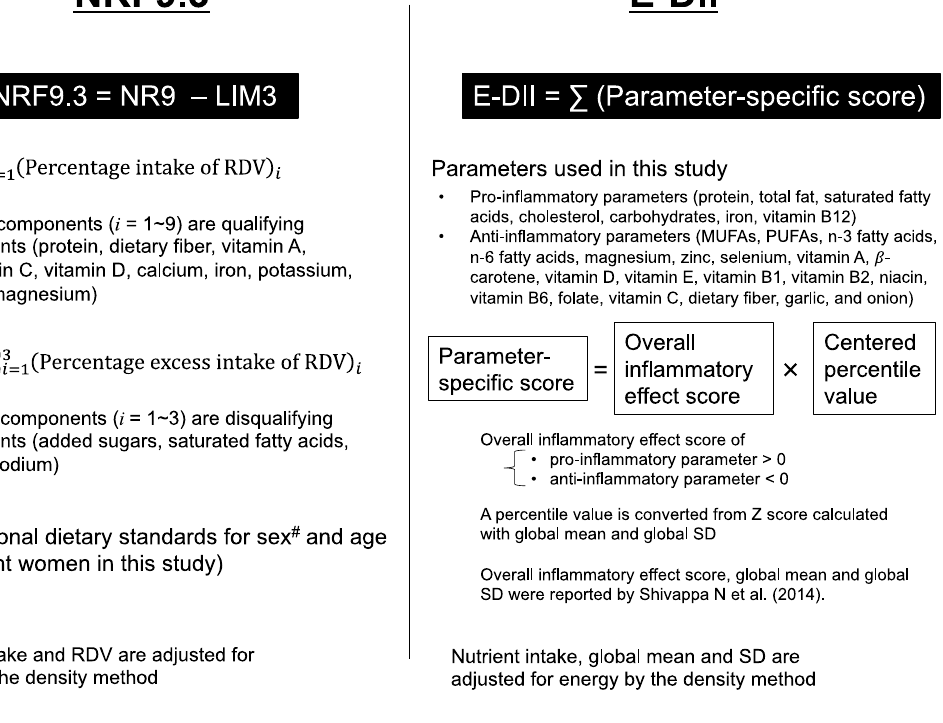
Figure 1. Summary of the dietary indices used in this study. The Nutrient-Rich Food Index 9.3 (NRF9.3) represents adherence to the national dietary intake standards [17,18]. The dietary Inflammatory Index (DII) is a comprehensive index of diet-derived inflammatory capacity, calculated using a common global mean and standard deviation (SD) deduced from the globally representative world database reported by Shivappa N et al. [19]. The energy adjusted DII (E-DII) is often used as an improved version of DII [20]. The details of these indices are described in the Materials and Methods section; NR, nutrient-rich; LIM, limiting nutrients; RDV, reference daily value; MUFAs, monounsaturated fatty acids; PUFAs, polyunsaturated fatty acids.